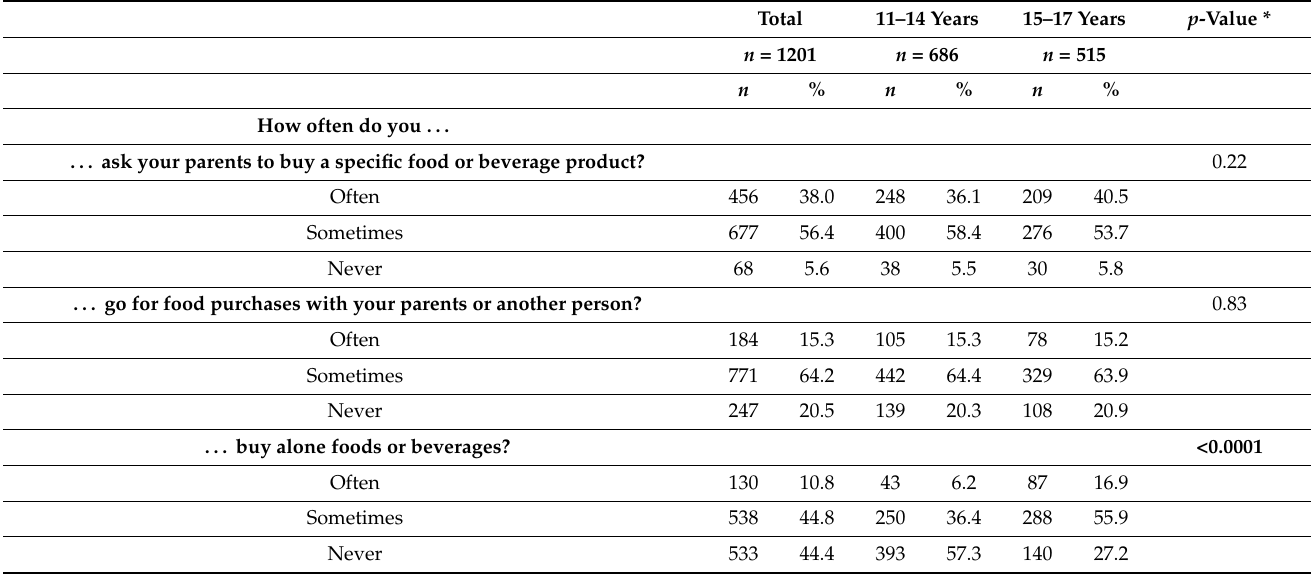
Table 2. Purchasing practices of adolescents on foods and beverages ( n = 1201–weighted